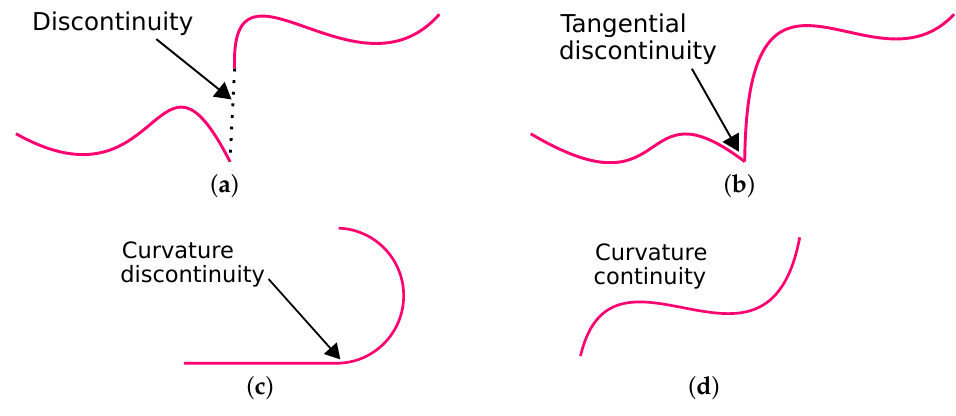
Figure 2. Parametric continuity. ( a ) Discontinuous curve segments. ( b ) C 0 continuity. ( c ) C 1 continuity. ( d ) C 2